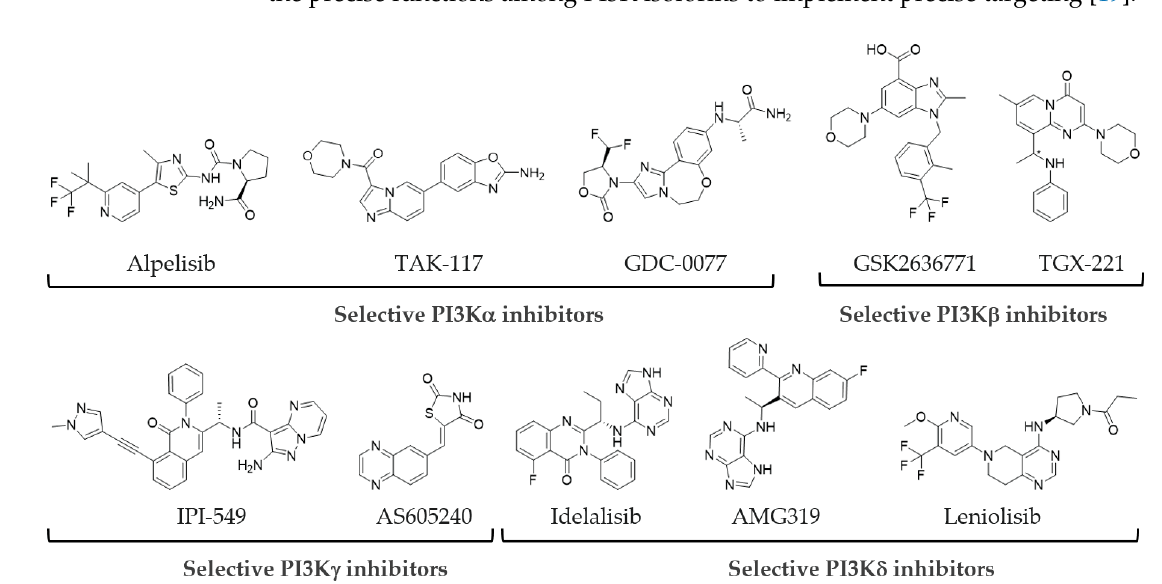
Figure 1. Binding pocket insights into PI3K isoforms. Sequence alignment indicates the conserved and variable residues in each PI3K isoform [21].